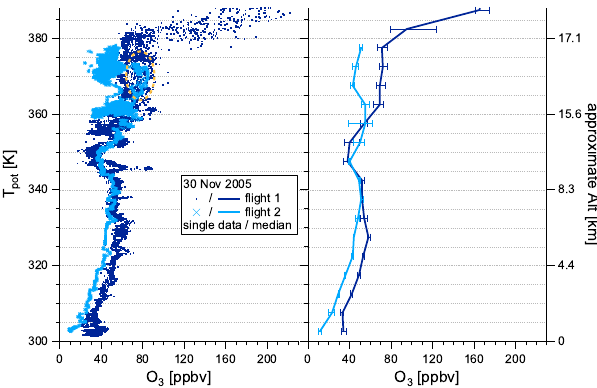
Figure 6. Profiles of ozone mixing ratios from first and second flight on 30 November 2005. Individual (1Hz) data points are shown in the left panel, median and 33 / 67 percentiles in the right panel. The orange ellipse encloses data points that were recorded at the begin- ning of the second flight at the eastern edge of the flight path. The number of these points is much lower than those at later times of the flight, thus these observations have no visible effect on the median as shown in the right